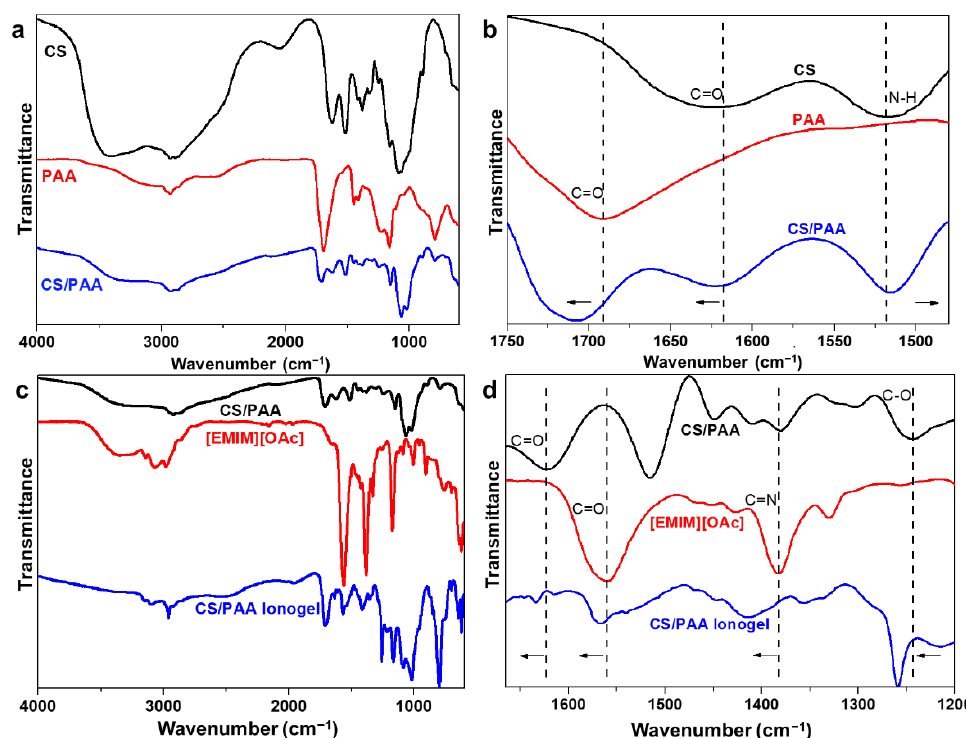
Figure 1. FTIR spectra of CS, PAA, and dried CS/PAA networks in a broad wavelength range of 4000 – 400 cm −1 ( a ) and a selected range of 1750 – 1480 cm −1 ( b ); FTIR spectra of ionic liquid [EMIM][OAc], dried CS/PAA networks and CS/PAA DN ionogel in a broad wavelength range of 4000 – 400 cm −1 ( c ) and a selected range of 1665 – 1210 cm −1 ( d ).